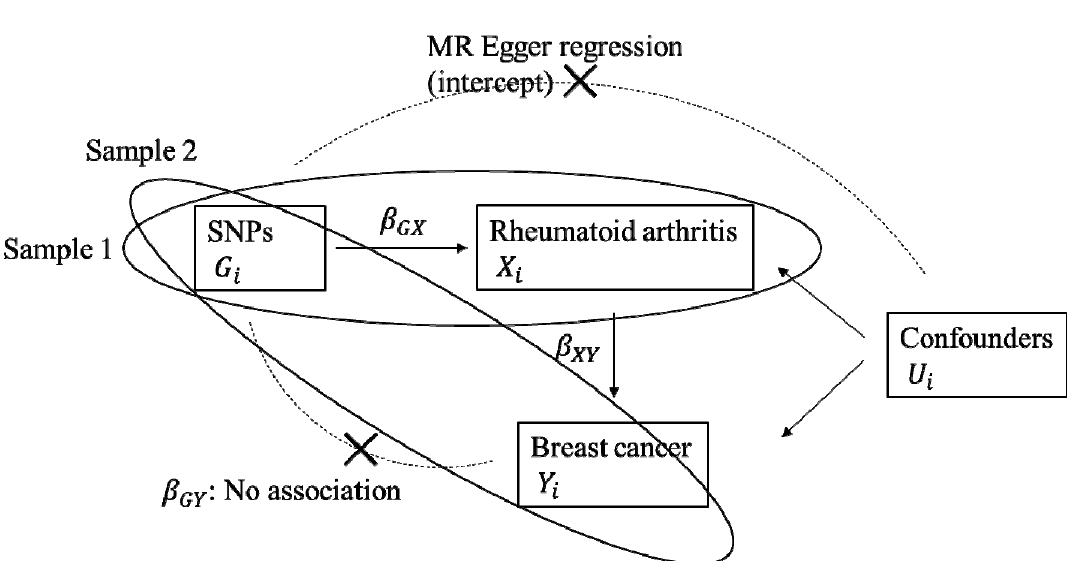
Figure 2. Two-sample Mendelian randomization testing the causal effect of rheumatoid arthritis (RA) on the risk of breast cancer. Estimates of the single nucleotide polymorphisms (SNPs)-RA association ( β GX ) were calculated in ‘Sample 1’ and the estimates of the SNPs-breast cancer association ( β GY ) were calculated in ‘Sample 2’. Finally, the estimates of SNPs are combined using the two-sample MR approaches, using penalized robust inverse variance weighted analysis ( β IV ) to confirm an overall causal estimate of RA on breast cancer risk and penalized robust MR-Egger regression with intercept to evaluate the possibility of pleiotropy. G i , SNPs; X i , Rheumatoid arthritis; U i , Confounders; Y i , Breast cancer .